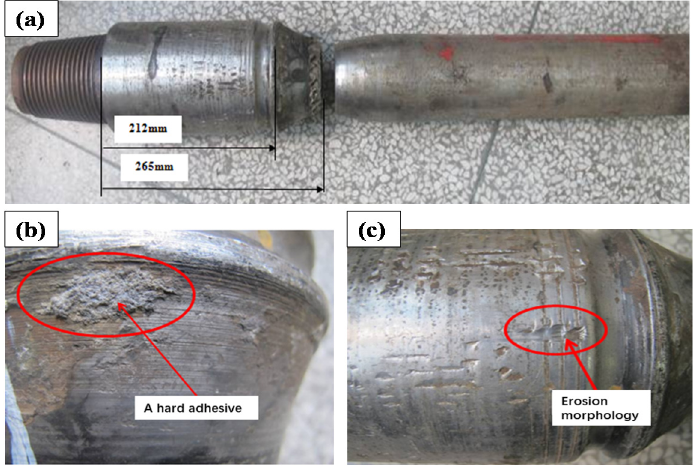
Figure 1. Macro morphology of failed drill pipe sample, ( a ) Macro topography of failed drill pipe; ( b ) Hard adhesive; ( c ) Erosion morphology.